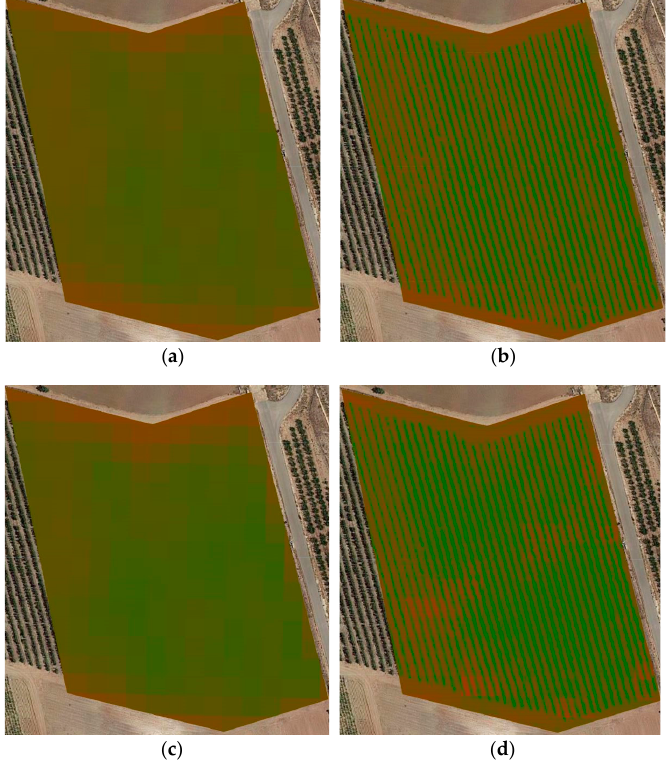
Figure 3. ( a ) NDVI image generated from the Sentinel 2-2A image of 25 July 2019, ( b ) Corresponding merged NDVI image ( c ). -NDVI image generated from the Sentinel 2-2A image of 18 September 2019, ( d ) Corresponding merged NDVI image. Low NVDI values are represented in reddish colors, high values-in greenish colors.